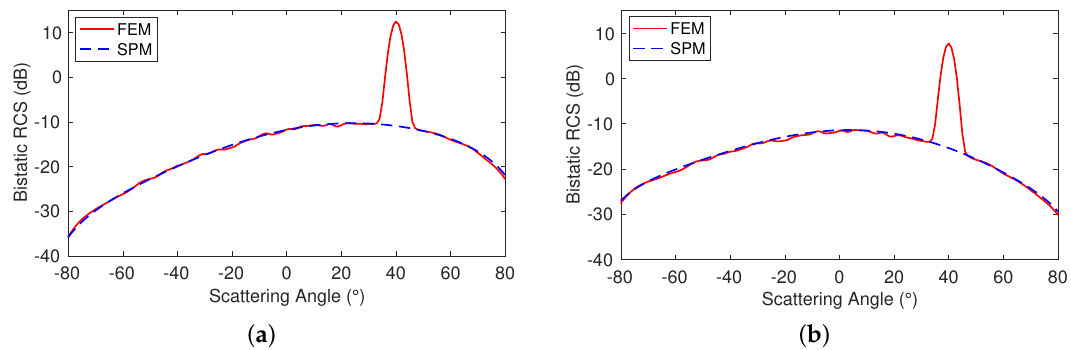
Figure 2. Bistatic radar cross section (RCS) of ( a ) HH and ( b ) VV polarizations simulated by the Finite Element Method (FEM) and the small perturbation method (SPM) for incidence angle θ i = 40 ◦ at